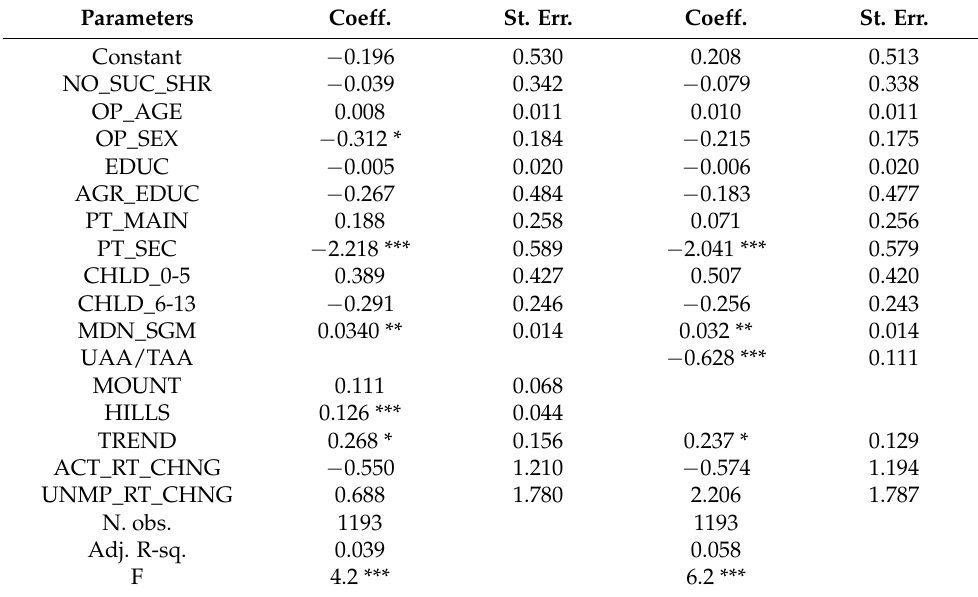
Table 5. Parameter estimates of the TAA decrease rate model. Parameters